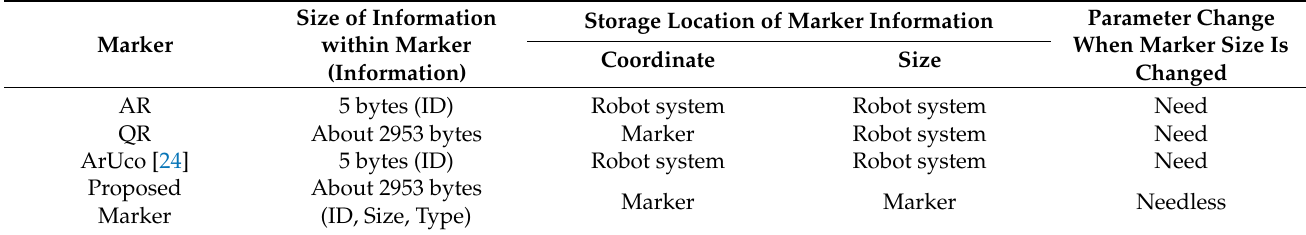
Table 2. Characteristics of markers used in camera positioning